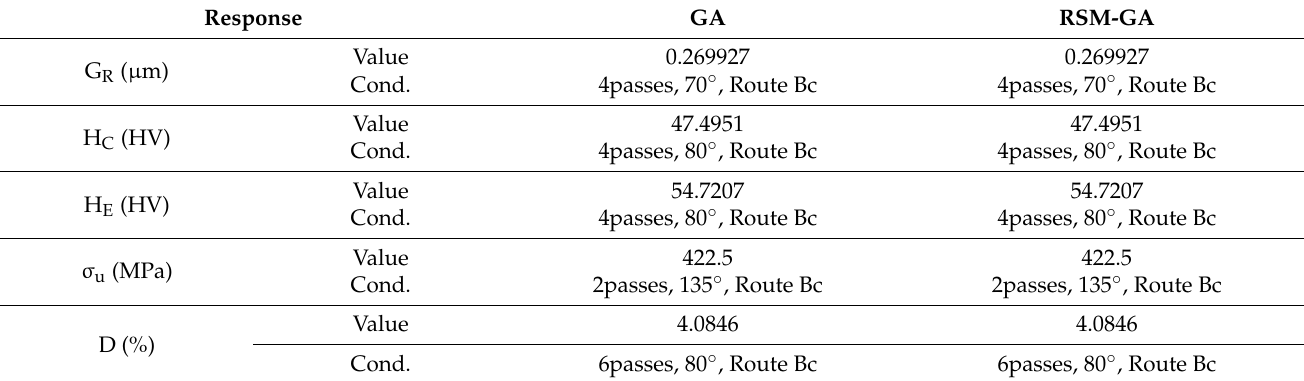
Table 6. Validated ECAP response based on previous